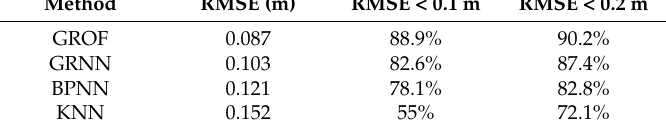
Table 3. Accuracy and precision of different algorithms in the line-of-sight (LOS) condition.